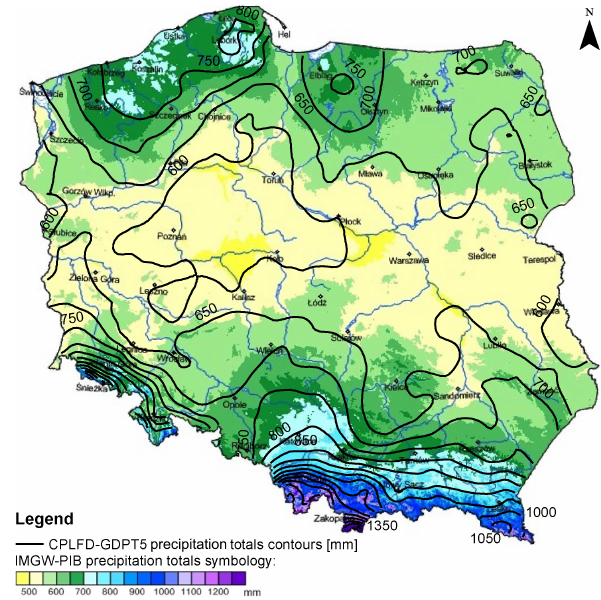
Figure 12. Comparison of CPLFD-GDPT5 precipitation-totals contours with IMGW-PIB precipitation-totals map for the 1971– 2000 period. Contours are in 50mm intervals. The IMGW-PIB map indicates also major rivers (blue lines) and major cities (labelled black circles). The IMGW-PIB map is adapted from the Climatic Maps of Poland (IMGW-PIB,